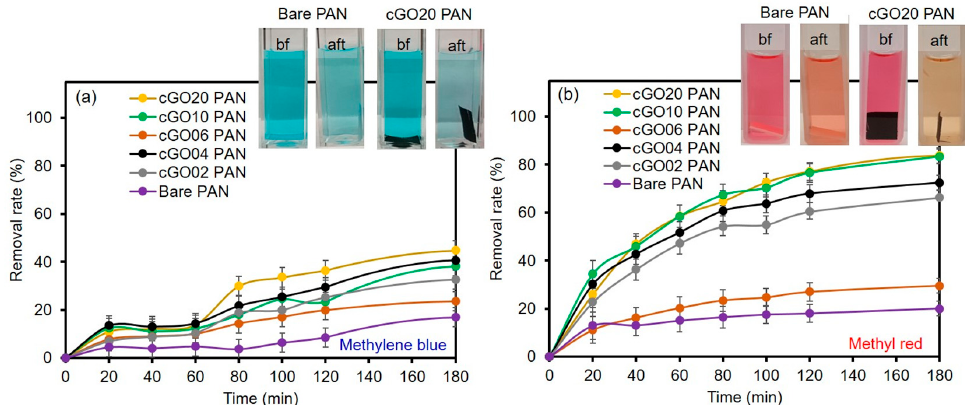
Figure 5. Removal rate of ( a ) MB and ( b ) MR by bare PAN and cGO–PAN composite nanofiber membranes as a function of time (representative color changes of 5 ppm dye solutions shown in digital photos). bf, before; aft, after.